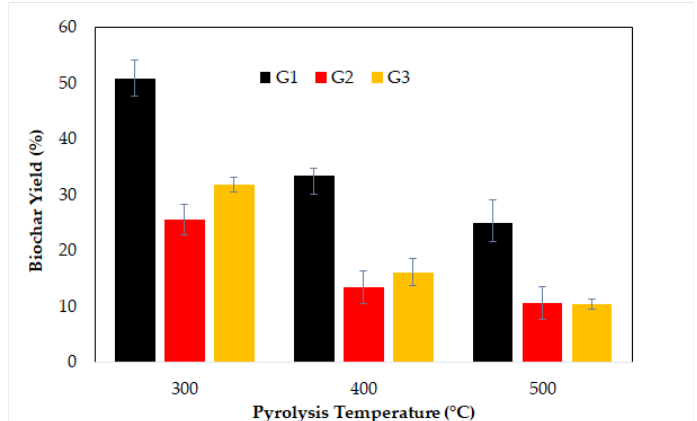
Figure 3. Biochar yield from CCA-treated wood at different granulometries (0.85 < G1 < 1.4 mm; 1.4 < G2 < 2 mm; and 2 < G3 < 3.35 mm) as a function of different pyrolysis temperatures (300, 400, and 500 °C).